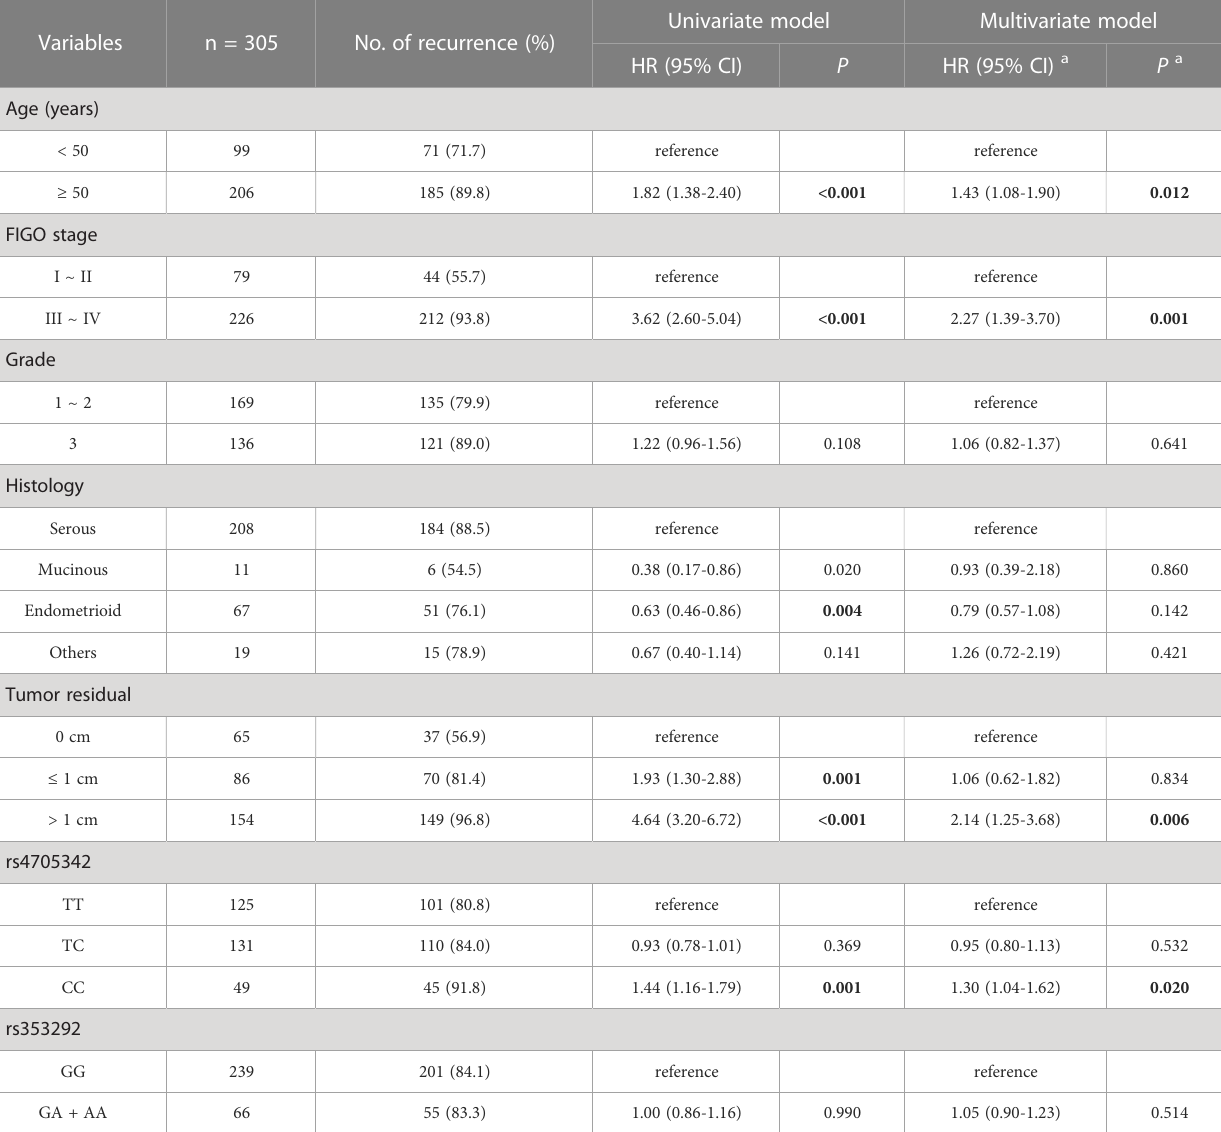
TABLE 3 Association of variables with the 5-year progression-free survival of epithelial ovarian cancer patients.